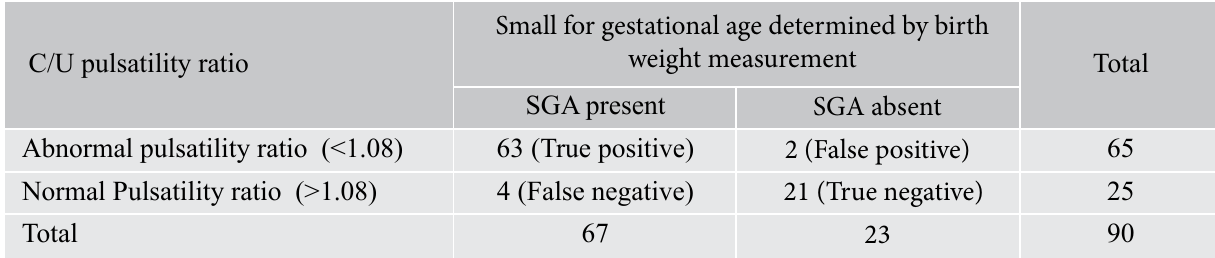
Table VI: Color Doppler evaluation of cerebral-umbilical pulsatility ratio correlation with small for gestational age